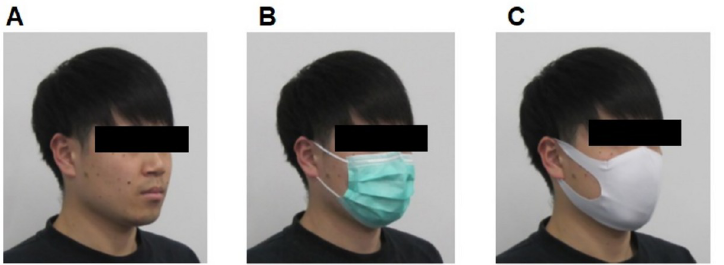
Fig 1. Three facemask conditions. Each participant underwent progressive treadmill tests under 3 conditions: without a facemask (A), wearing a surgical facemask (B), and wearing a cloth facemask (C) in randomized order. Both types of facemasks are widely used in hospitals and gyms as well as in daily life in